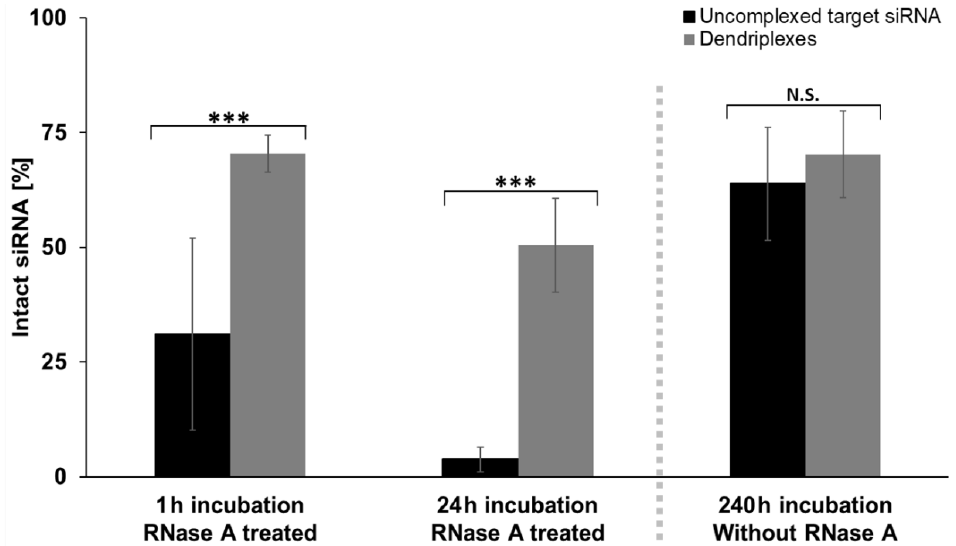
Figure 6. Influence of incubation time and RNase treatment on degradation of uncomplexed target siRNA or siRNA complexed in dendriplexes. Percentages of intact siRNA (in comparison to samples before incubation) after indicated incubation times were calculated as described in Section 2.4. RNase treatment was performed by adding 1 µ g/mL (final concentration) bovine RNase A to the sample directly before starting incubation at 37 ◦ C and 500 rpm. Concentration of siRNA at the start of each incubation was 100 nM, resulting in a theoretical concentration maximum of 10 nM in PCR reactions in case of no siRNA degradation. N/P ratio = 5 in all dendriplex samples. Three separate biological samples were prepared and each sample analyzed in PCR triplicate reactions for generation of each data bar. Significant differences between measurements with uncomplexed and complexed siRNA are indicated whenever identified by performing single factor variance analysis